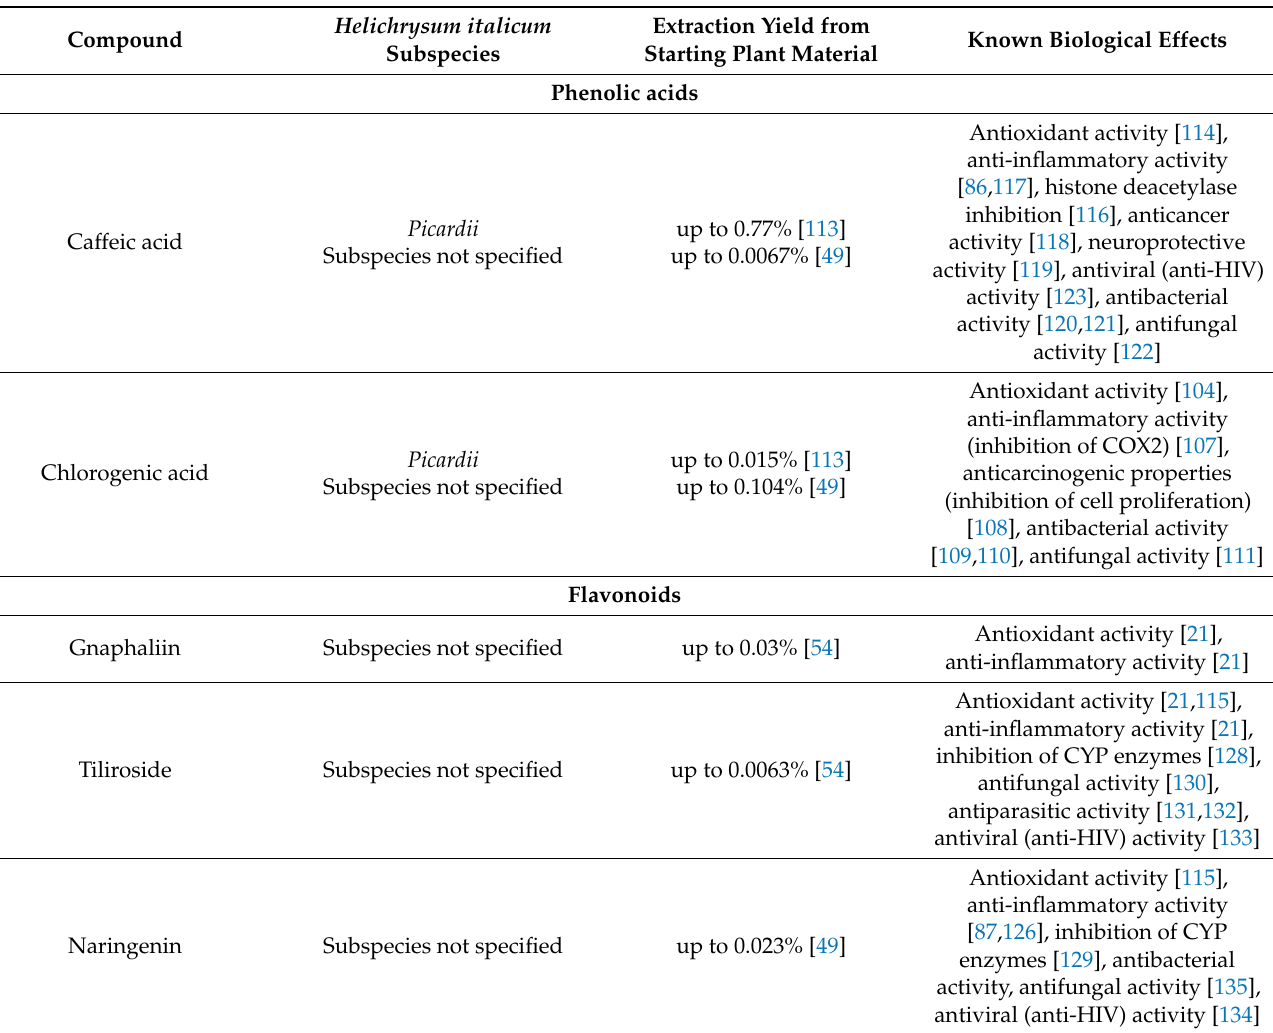
Table 3. Known biological effects of bioactive compounds from Helichrysum italicum